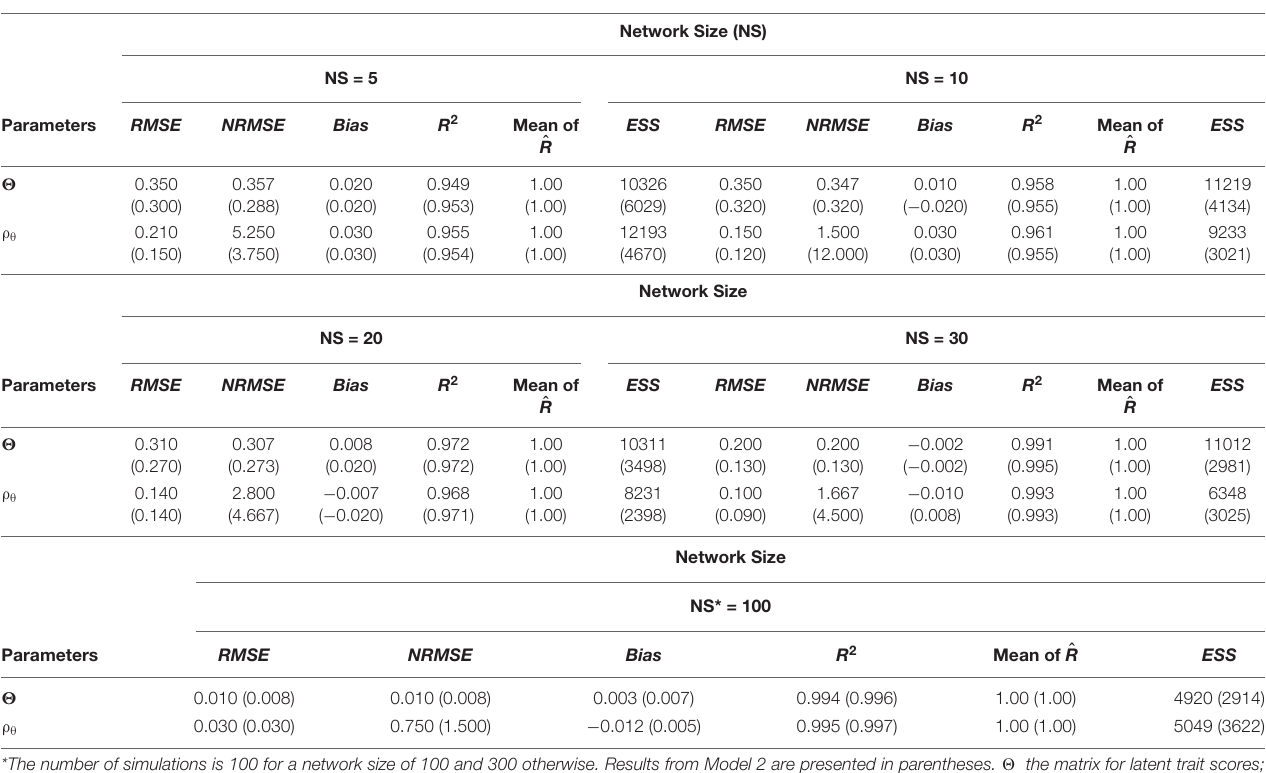
TABLE 6 | Root-mean-squared error ( RMSE ), normalized root-mean-squared error ( NRMSE ), bias, and coefficient of determination ( R 2 ) of parameter recovery, convergence diagnosis index ( ˆ R ) , and effective sample size ( ESS ) from model